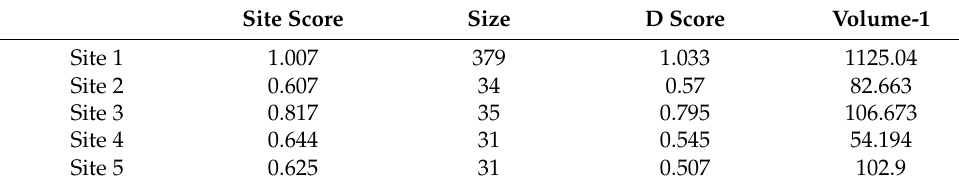
Table 1. Binding sites predicted by